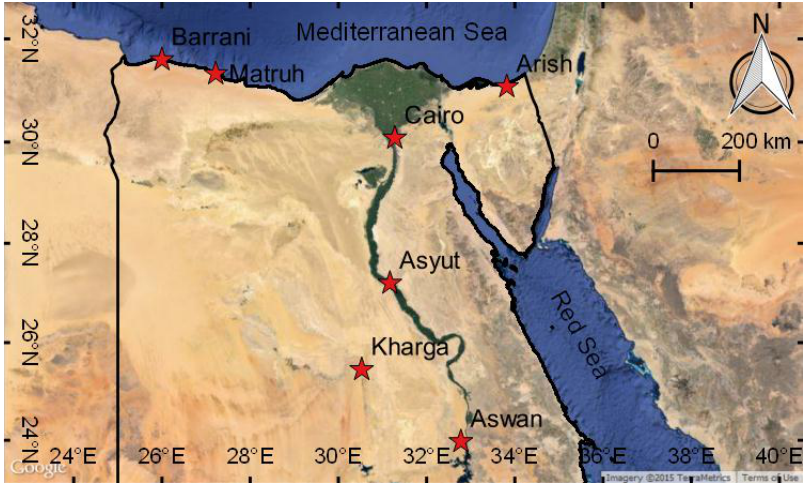
Figure 1. Map showing the locations and surroundings of the seven stations used in this